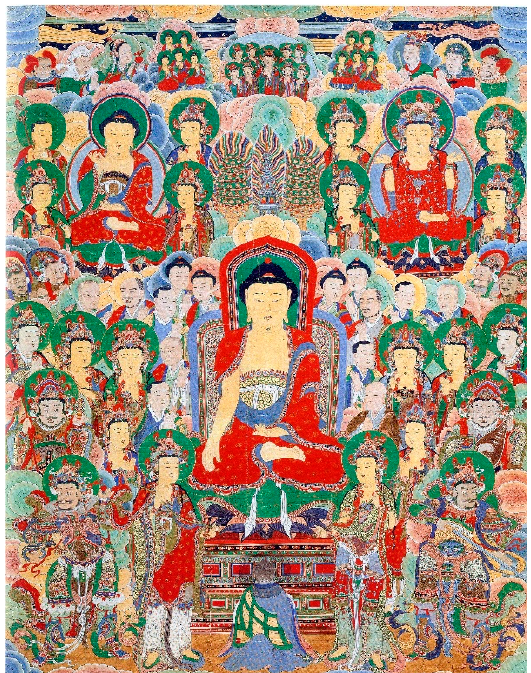
Figure 5. Assembly of the Buddha Triad (K. Sambulhoedo ), Joseon (1710), Color on hemp, 544 × 422 cm, Chiljangsa Temple (Research Institute of Sungbo Cultural Heritage 2003, p. 39). 3. Origin and Background to the Iconography and Its Adoption in Buddhist Painting